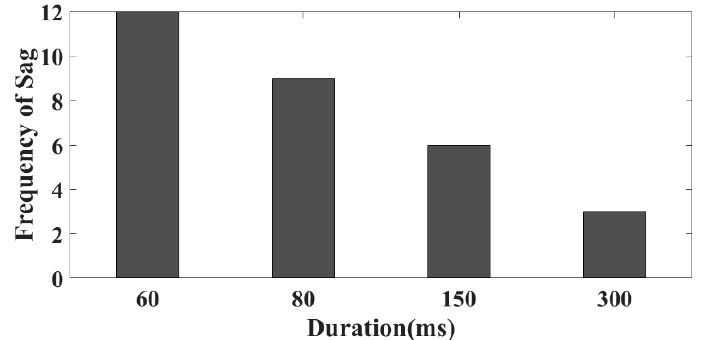
Figure 12. Frequency of sags versus duration on bus 10.